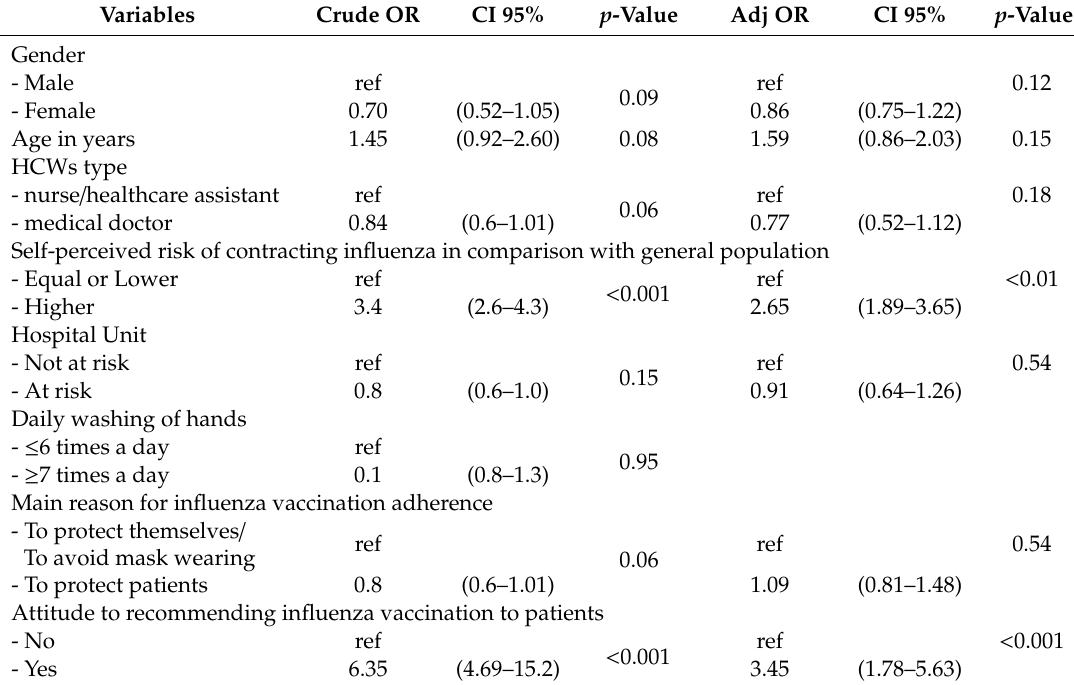
Table 3. Crude Odds ratio (OR) and Adj OR and related Confidence interval (CI 95%) variables associated with at least one influenza vaccination during last five influenza seasons at the three Sicilian University Hospitals (students and trainees were removed from the multivariable